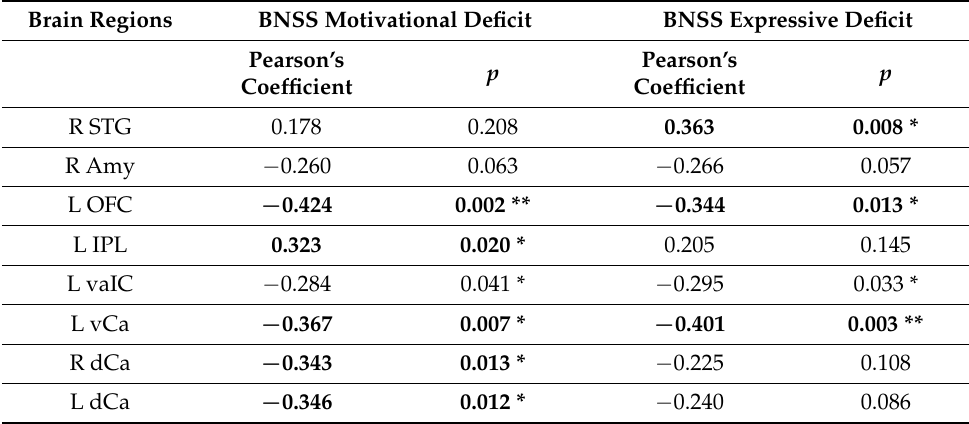
Table 3. Correlations between BNSS domains and resting-state